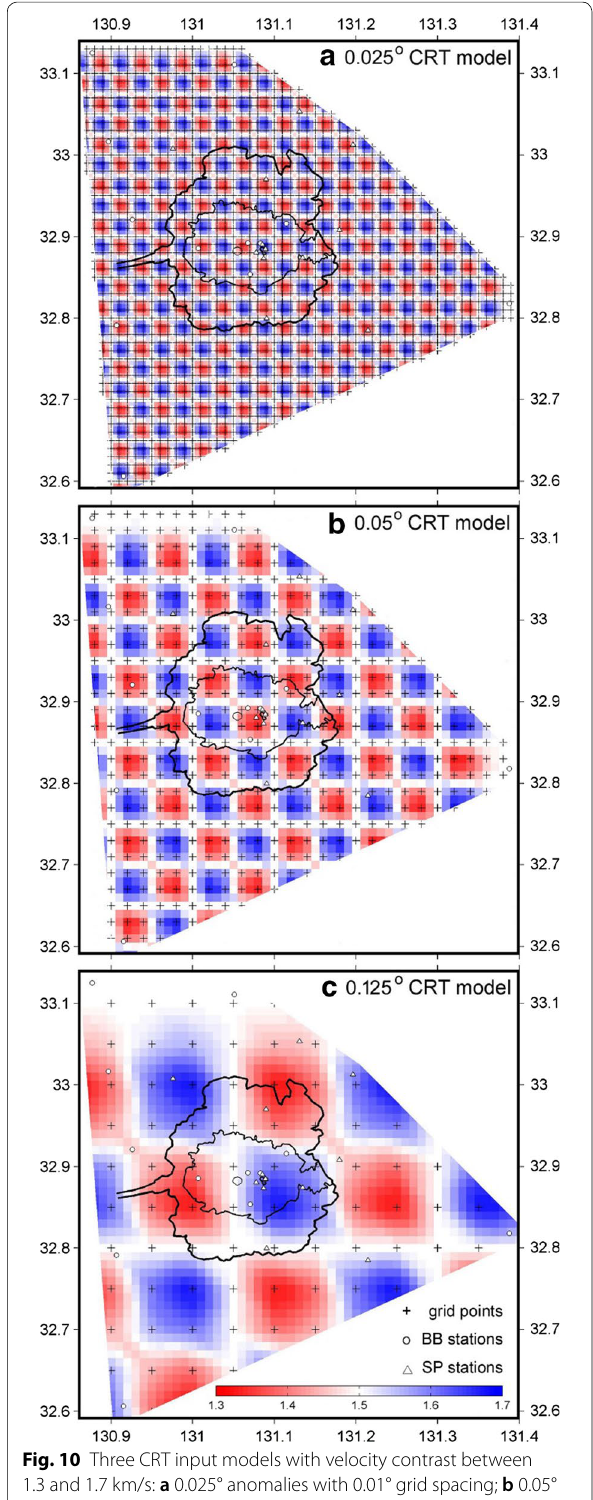
Fig. 10 Three CRT input models with velocity contrast between 1.3 and 1.7 km/s: a 0.025° anomalies with 0.01° grid spacing; b 0.05° anomalies with 0.02° grid spacing; and c 0.125° anomalies with 0.05° grid spacing. Large circle at the center of the post‑caldera central cones is Kusasenrigahama as shown in Fig.